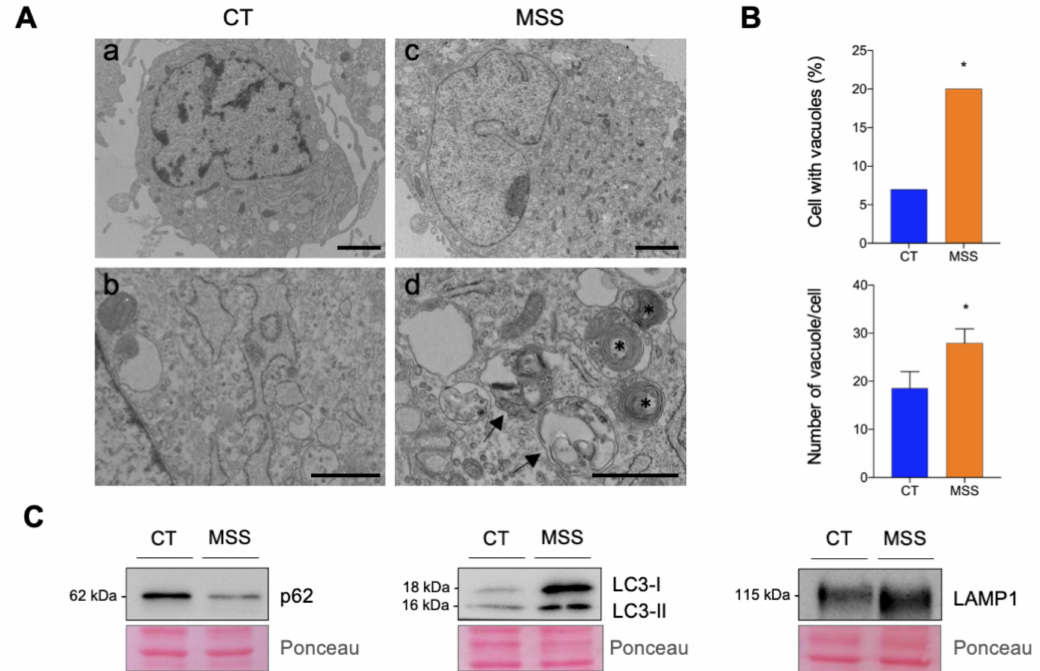
Figure 3. Electron microscopy (EM) and immunoblot analysis of autophagic vacuoles. ( A ) Ultrastructural alterations in HF-MSS. Representative EM micrographs of HF-CT (a) and HF-MSS (c) cells. Details at higher magnification of the cytoplasm of HF-CT (b) and HF-MSS (d) cells. HF-MSS cells accumulate vacuoles containing large clusters of membranes (arrowheads) and multilamellar bodies (asterisks). Scale bars: a and c: 2 µ m; b and d: 1 µ m. ( B ) Upper graph, percentage of HF-CT and HF-MSS cells exhibiting vacuoles/multilamellar bodies ( n = 100 cells/group); lower graph, average number of vacuoles/multilamellar bodies per cell calculated by considering only the cells showing such structures. Statistical significance Chi square test (lower) and t -test (upper) * p < 0.05. ( C ) HF-CT (CT) and HF-MSS (MSS) cultured under standard growth conditions were analyzed by Western blotting for the expression of p62/SQSTM1 (p62), LC3, and LAMP1. Immunoblots are representative of at least two independent experiments. Ponceau S staining of the blots is shown to control for equal protein